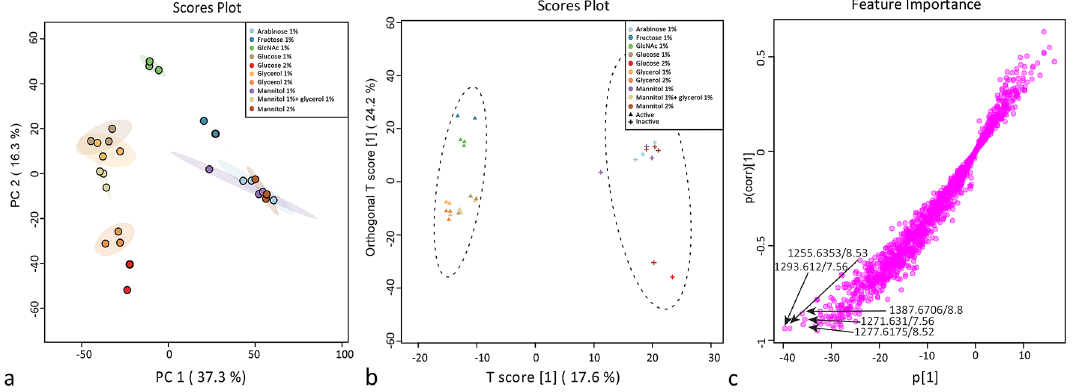
Figure 1. Differential production of metabolites depending on the carbon source. ( a ) PCA score plot of Streptomyces sp. MBT27 metabolites produced in cultures with different carbon sources, namely, 1% arabinose, 1% fructose, 1% GlcNAc, 1% glucose, 2% glucose, 1% glycerol, 2% glycerol, 1% mannitol, 1% mannitol + 1% glycerol and 2% mannitol (%ages in w/v). ( b ) OPLS-DA score plot. Triangles and crosses represent samples of active and inactive groups respectively, circular areas represent the 95% confidence region of each group. ( c ) OPLS-DA loadings S-plot. Arrows indicate the most discriminative features that positively correlate with the active